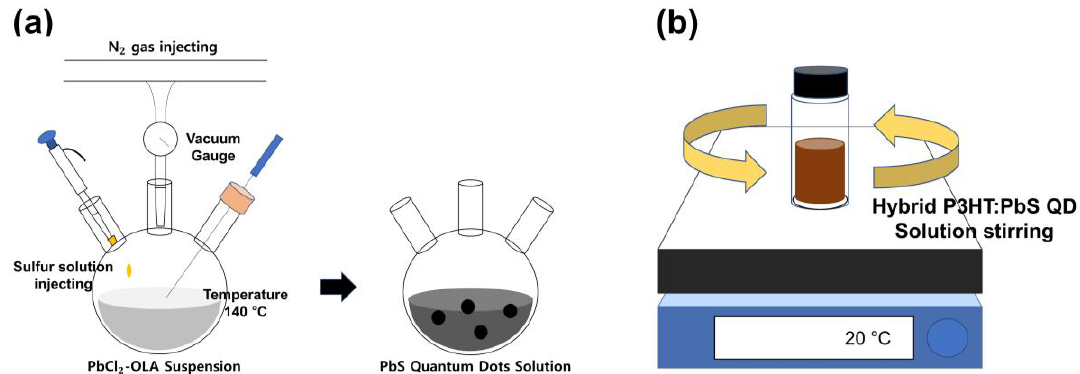
Figure 1. ( a ) Schematic diagram of PbS quantum dots synthesis process and ( b ) the fabrication process of hybrid P3HT:PbS QD solution.